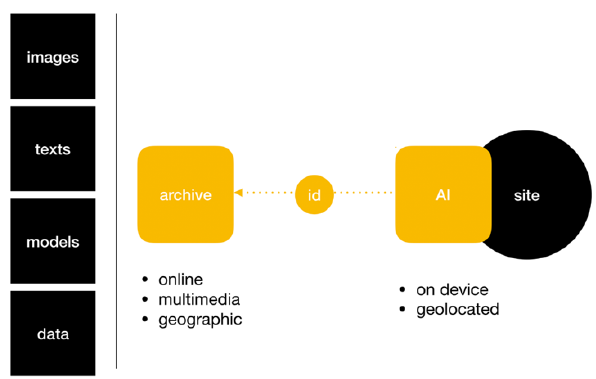
Figure 1. Scheme of the two main components of the app: the digital archive, storing data and documents, and the artificial intelligence engine, interacting with the site through the